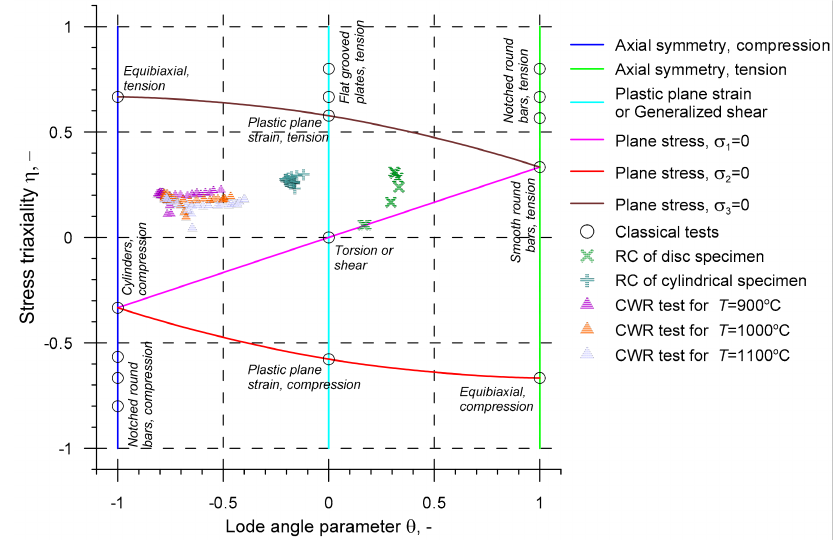
Figure 18. Stress triaxiality in the CWR test and other tests used for damage function